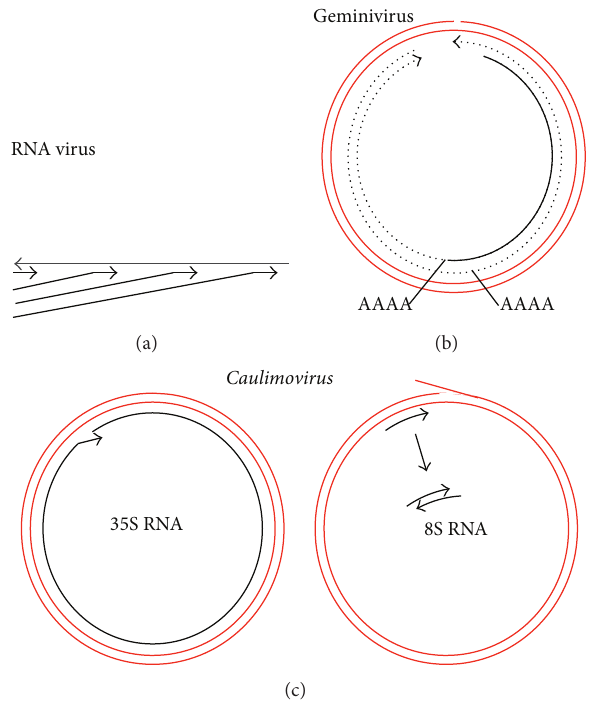
F 2: Viral dsRNA formation. (a) RNA-virus RNAs are repli- cated by viral RNA polymerases producing plus strands from a minus strand and vice versa. Occasionally, dsRNA is formed, namely, before the viral strands can be packaged or are protected by ribosomes. (b) Read-through transcription prior to polyadenylation leads to overlapping transcripts in geminiviruses. (c) �au�i�o��r mosaic virus and other caulimoviruses produce a speci�c dsRNA covering the leader region. is dsRNA and its siRNA products are thought to act as decoy, the latter by forming nonfunctional RISCs.